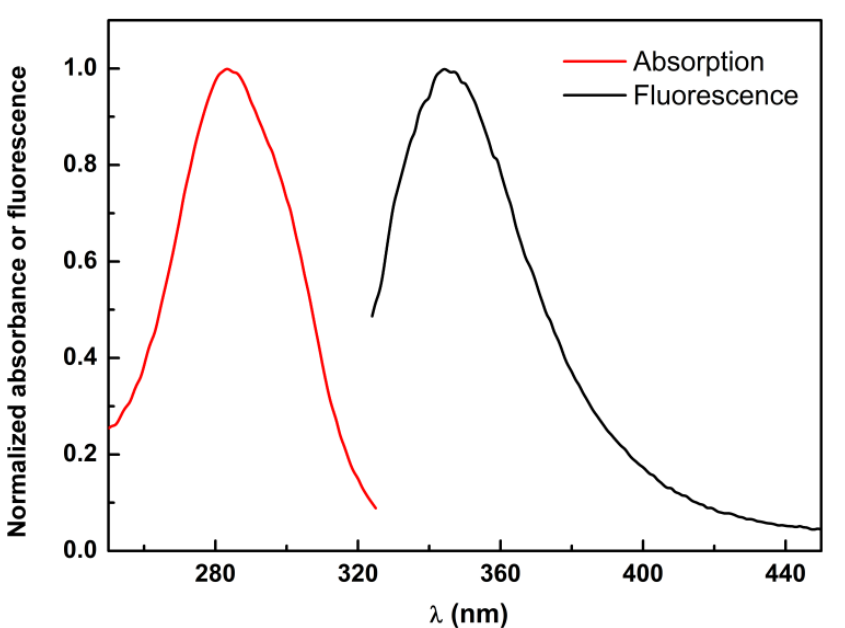
Figure 6. Normalized absorption and fluorescence emission (excitation at 290 nm) spectra of 3f solution (2 × 10 − 5 M for absorption and 5 × 10 − 6 M for emission). Table 4. Encapsulation efficiency (EE%) of compound 3f in DMPG (100%) and DMPG/DPPC (50:50) liposomes and concentration of encapsulated compound.